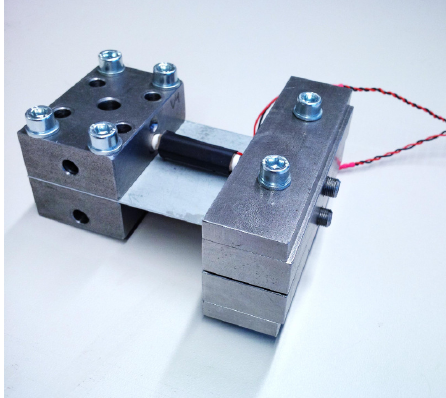
Figure 7. Implemented prototype of the adaptive vibration